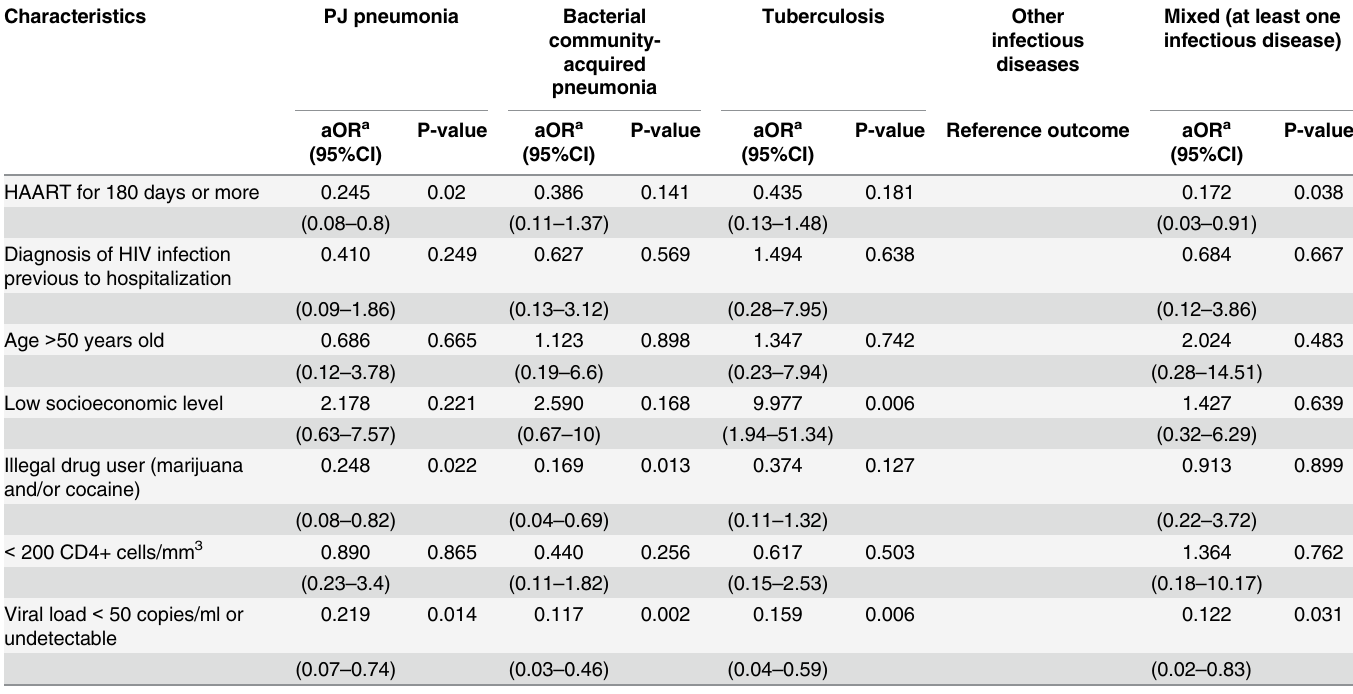
Table 4. Association between respiratory disease and HAART for 180 days or more, adjusted for clinical characteristics, in HIV/AIDS patients from a specialty hospital for respiratory diseases in Mexico City from January 2010 to December 2011.